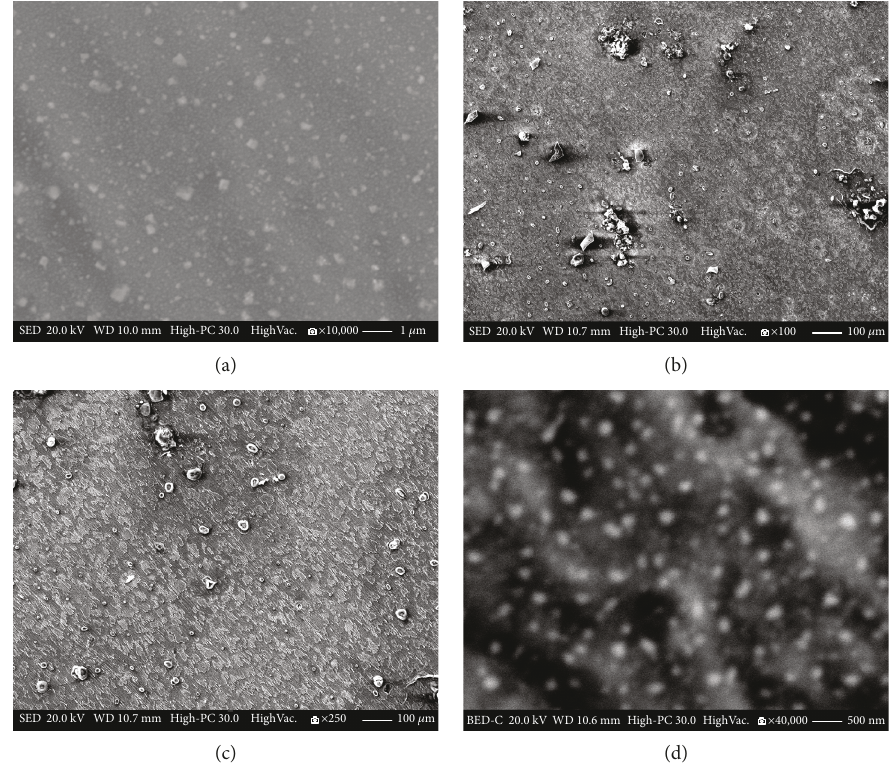
Figure 20: Morphological aspects of carbon steel coated with a fi lm of chitosan doped with 1000 ppm of nanoparticles, after 24 hours of immersion in a 3.5% NaCl solution at room